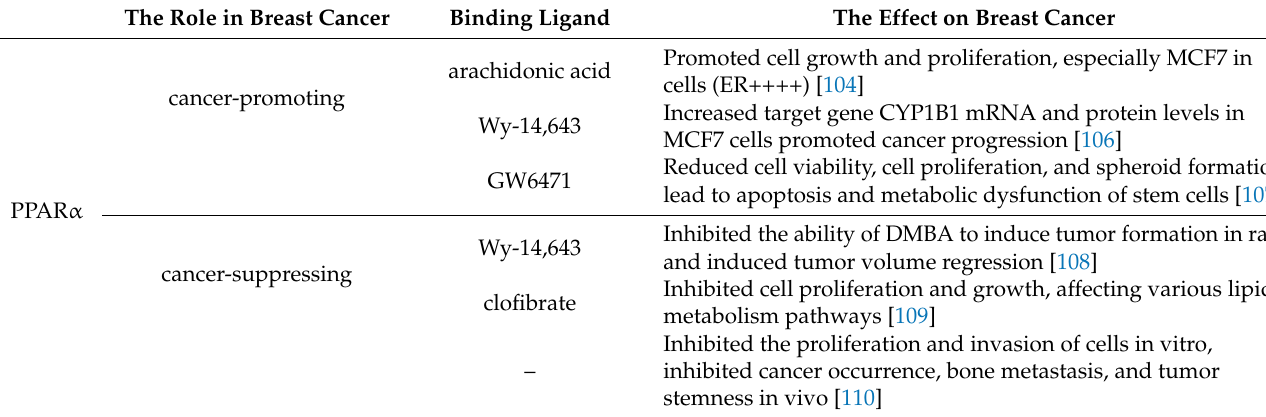
Table 2. The effects of PPAR α on breast